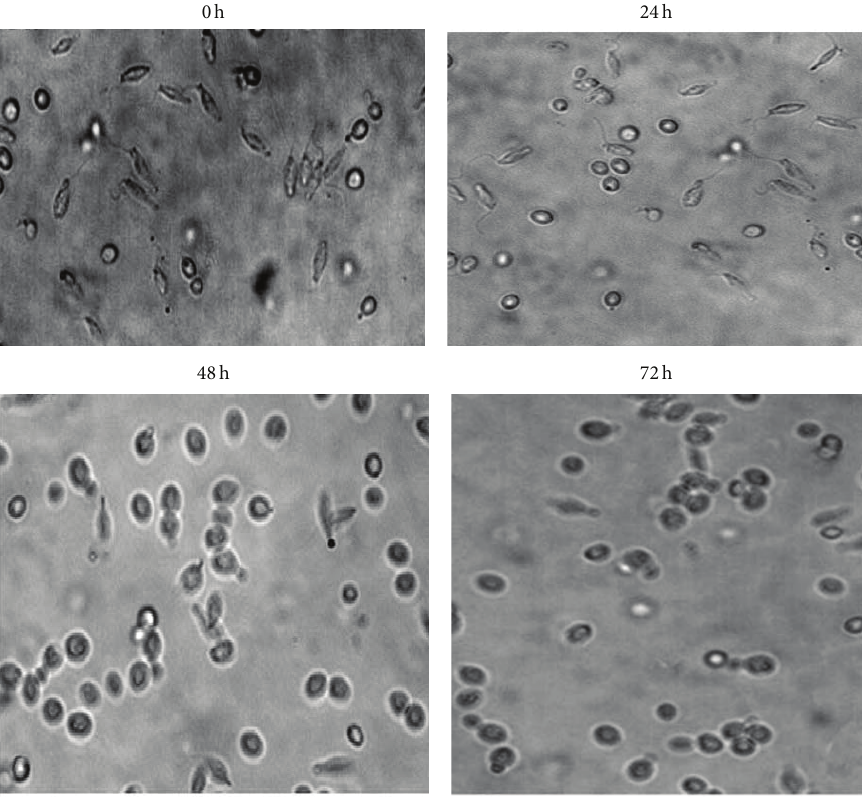
Figure 4: Morphological changes of L. infantum promastigotes treated with coelomic fluid extract (22.5 𝜇 g/mL) at different time point after 24, 48, and 72